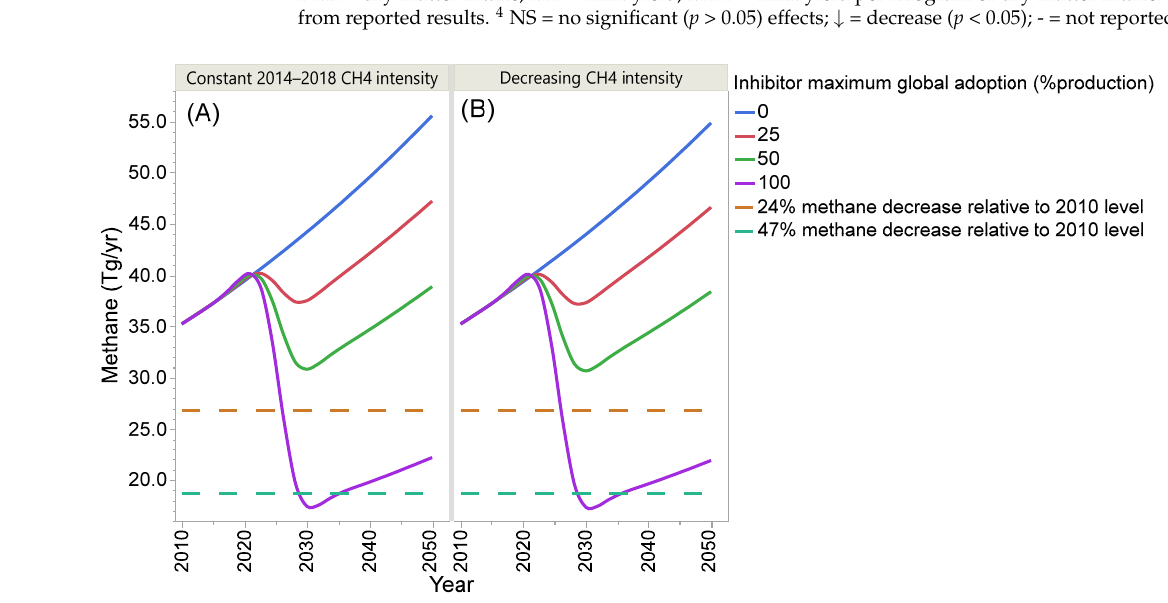
please refer to Table S1. 2 Abbreviations: 3-NOP = 3-nitrooxypropanol; CH 4 = methane; DM = dry matter; DMI = dry matter intake; MY = milk yield; MY:F = milk yield per kilogram of dry matter intake. 3 Calculated